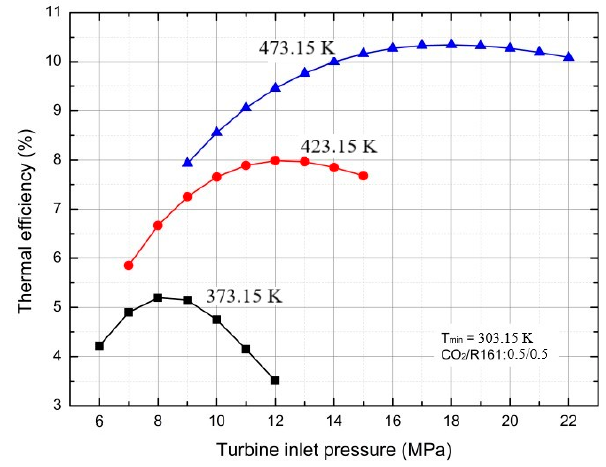
Figure 8. The relationships between thermal efficiency and turbine inlet pressure under various turbine inlet temperatures.